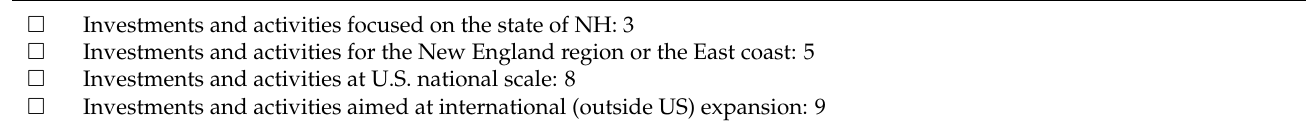
Table 7. The scope of FDI and FDI or supply chain-related activities affecting